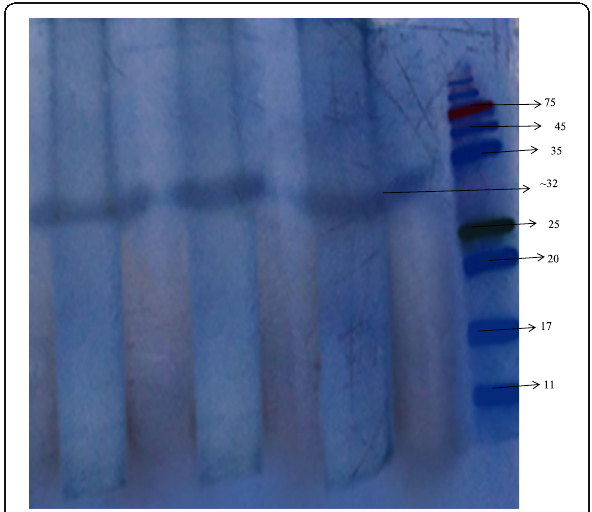
Fig. 1 SDS-PAGE of purified serratiopeptidase. The molecular mass of purified serratiopeptidase was determined by comparing with protein